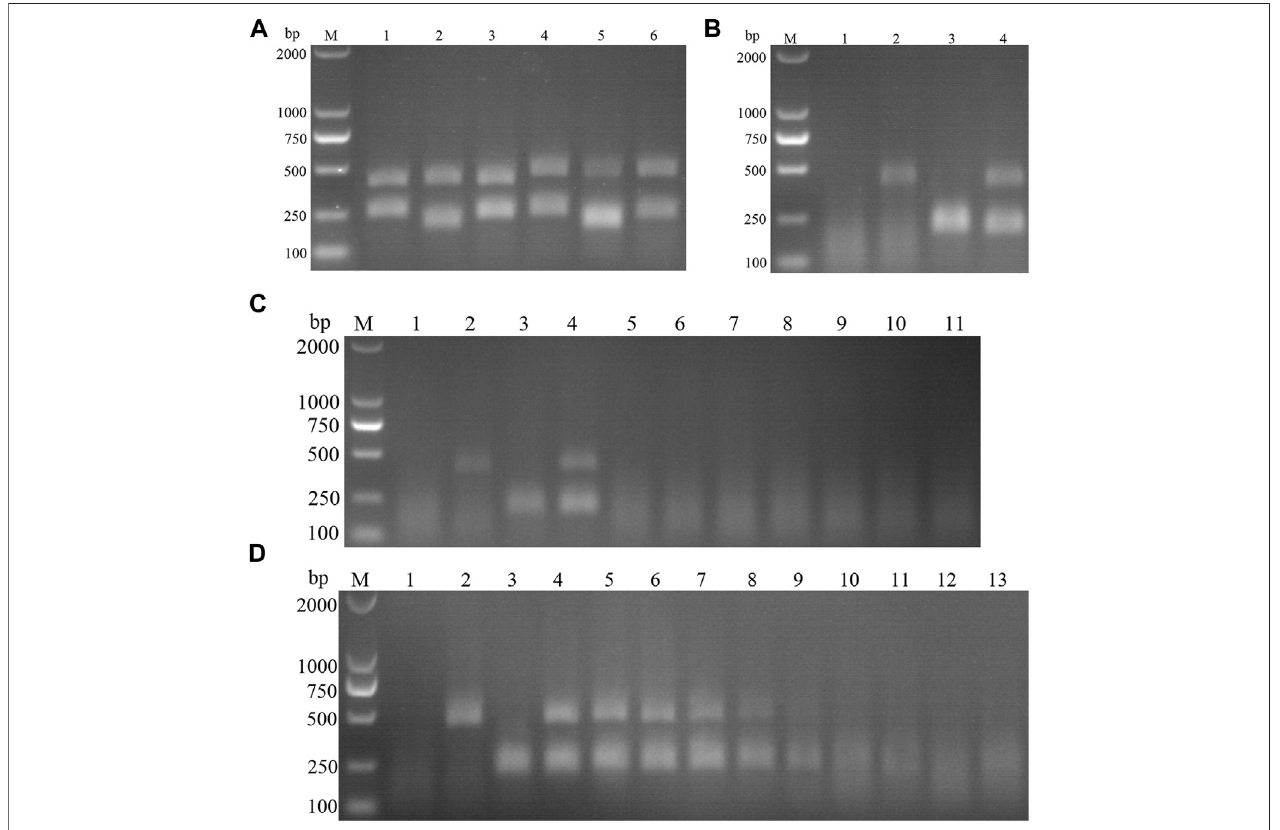
FIGURE 13 | (A) Primer screening for dual RAA. M is a 2,000 bp DNA marker. The primers used in lane 1 – 6 successively are: ASF-RAA-F1/R1 and CSF-RAA F1/ R1,ASFV-RAA-F1/R1 andCSF-RAAF2/R2,ASFV-RAA-F1/R1and CSF-RAA F3/R3,ASFV-RAA-F2/R2 andCSF-RAAF1/R1,ASFV-RAA-F2/R2and CSF-RAA F2/R2